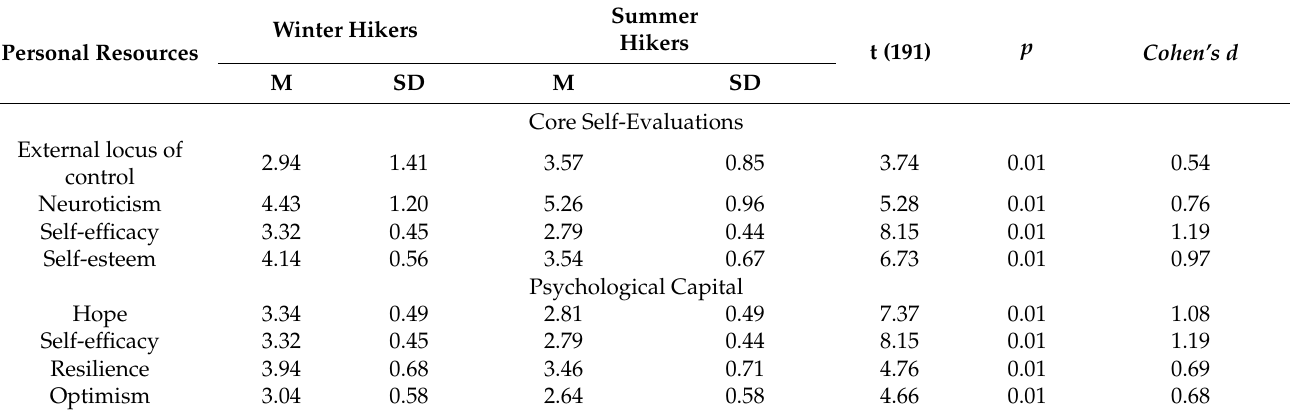
Table 1. Comparisons of Core Self-Evaluations and Psychological Capital in winter and summer hikers’